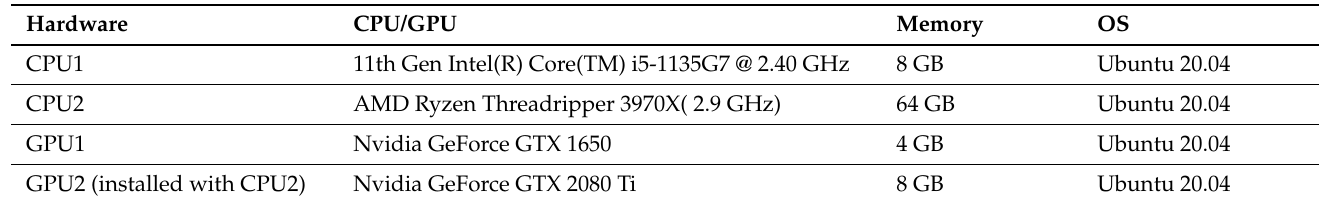
Table 2. CPU and GPU hardware used for computation in this study.